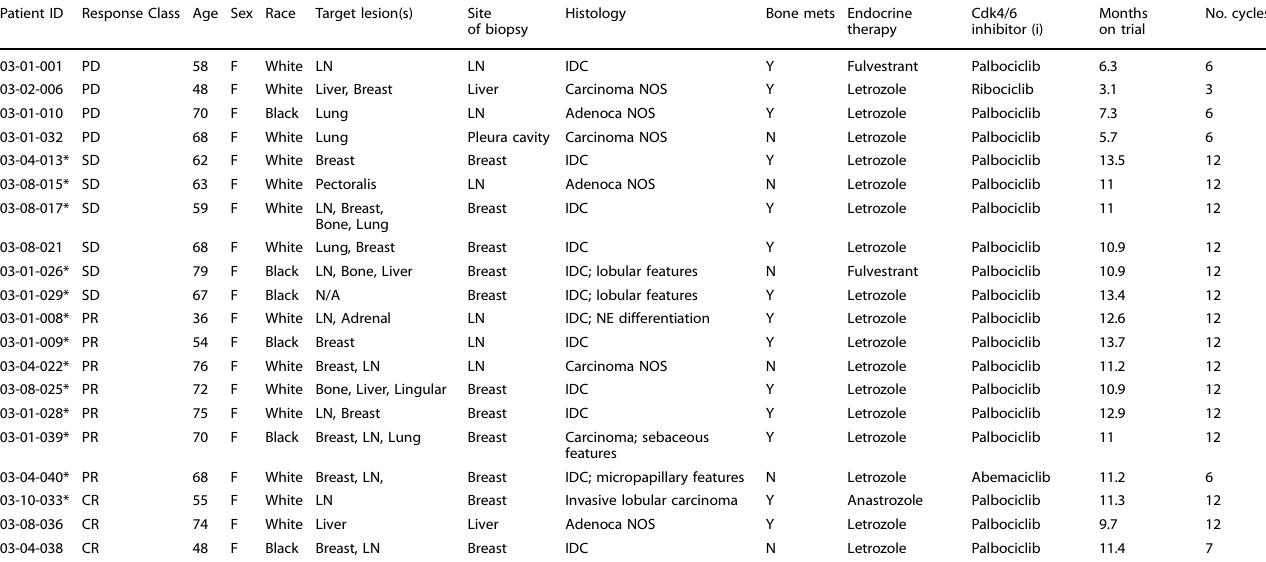
Table 1. Demographic characteristics, treatment regimens, and response class for 20 evaluable patients included in the study. Patient ID Response Class Age Sex Race Target lesion(s)